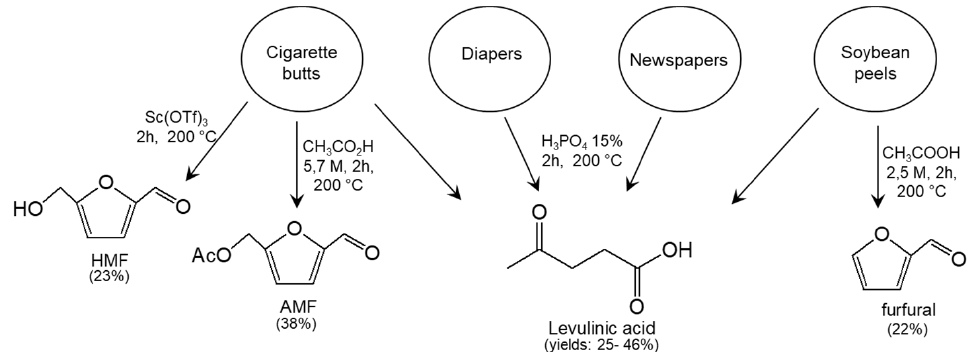
Scheme 3. Summary of the selective synthesis of AMF, HMF, levulinic acid, and furfural from